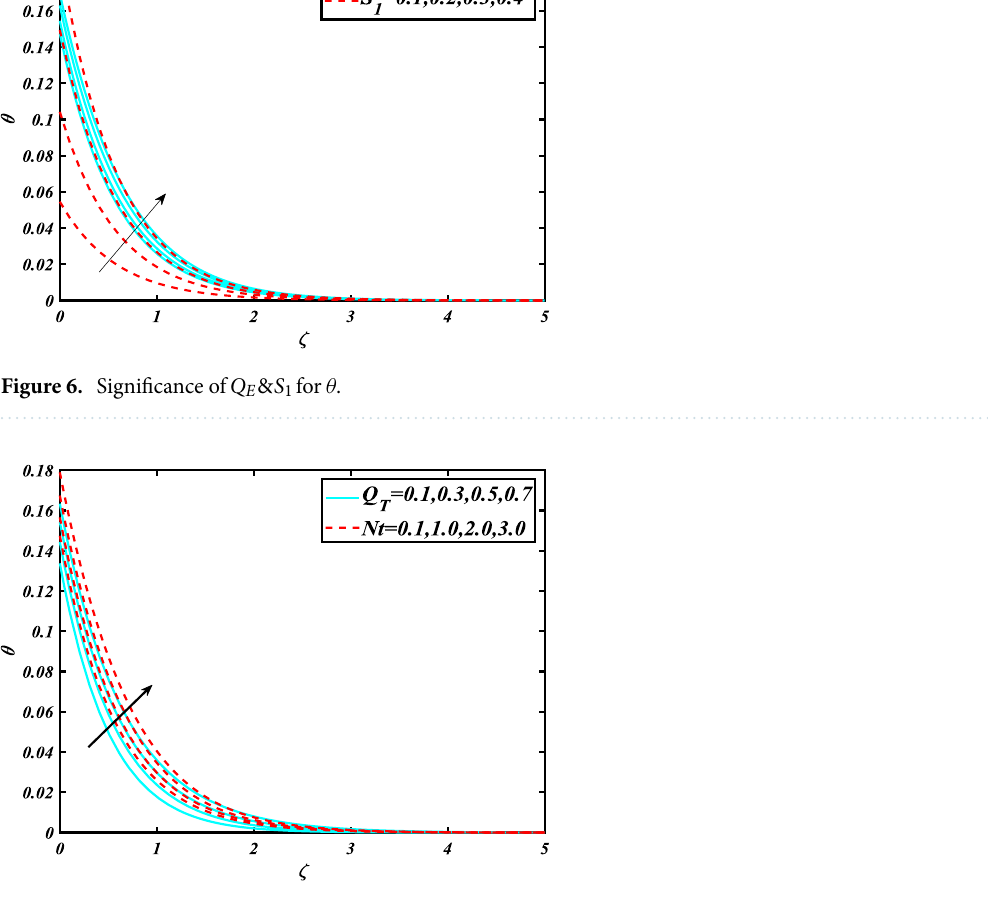
Figure 7. Significance of Q T & Nt for θ